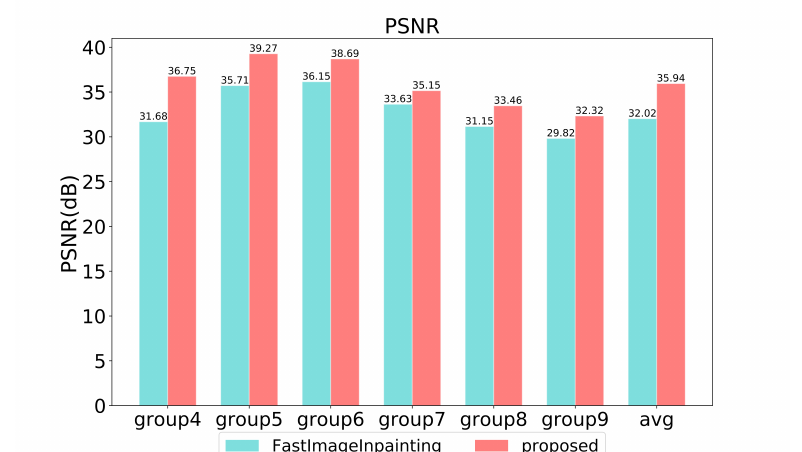
Figure 10. Quantitative results in terms of PSNR on TSD-max.